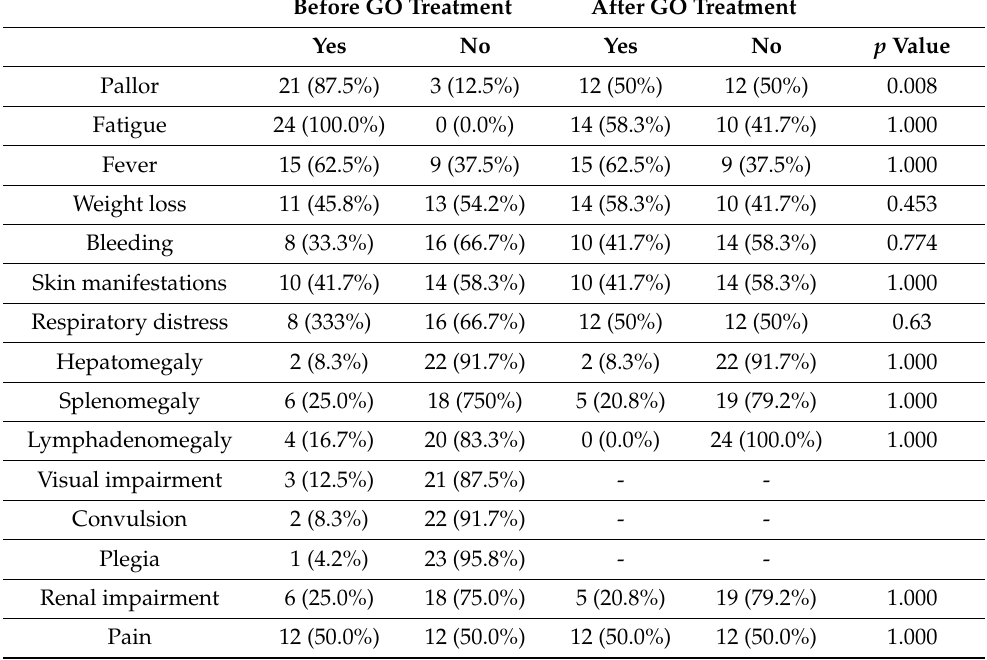
Table 2. Physical examination findings of the patients before and after treatment with GO.